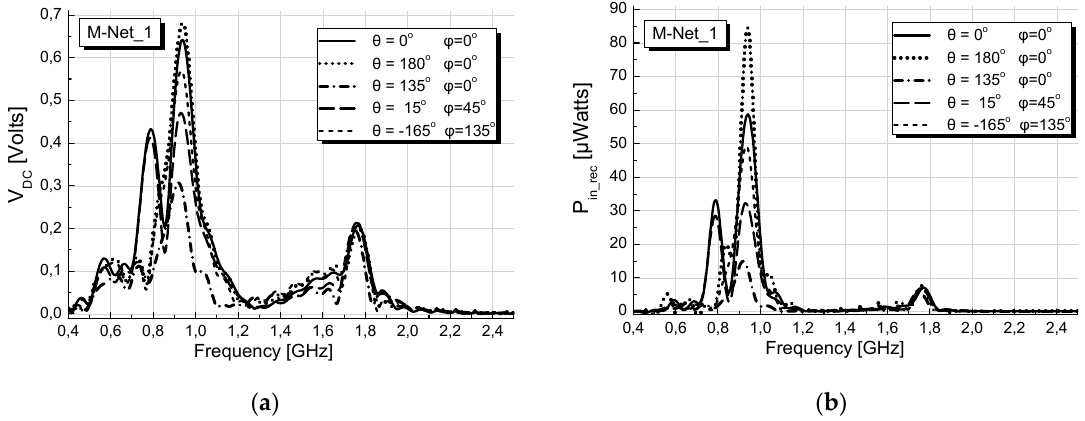
Figure 12. Results versus frequency when M-Net_1 is connected: ( a ) DC voltage at the output of the rectifier(rec1), ( b ) power available at the input of the rectifier.